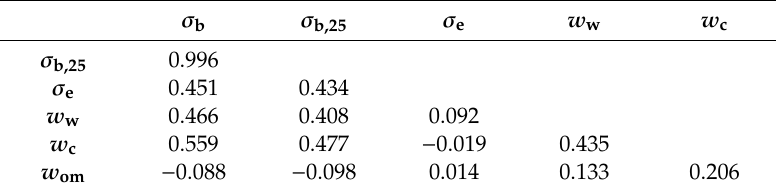
Table 9. Pearson’s product-moment correlation coe ffi cients among the EM38 σ b calculated values, and soil properties in the sites and depths the former were available.